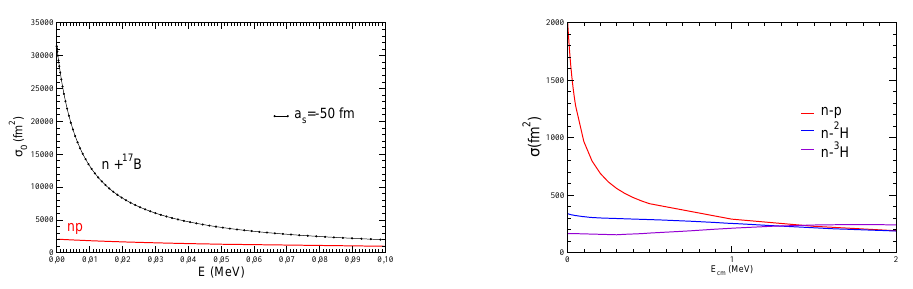
Figure 6: The low energy n - 17 B cross section as a function of the energy for a fixed = -50 fm is compared to the np case (left panel), which is in its turn compared value a S to the lightest nuclei in the rigth panel.